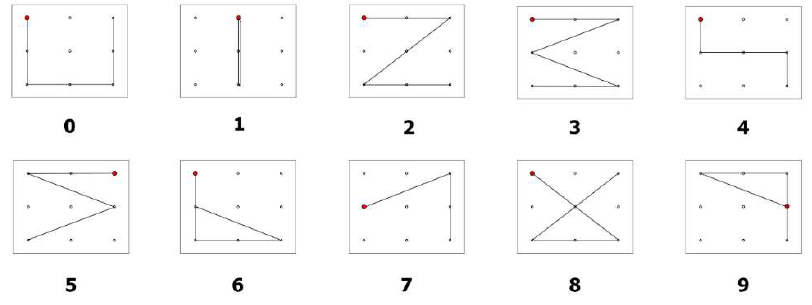
Figure 11. Design of eye-writing digits for individuals with ALS. Reprinted with permission [20].